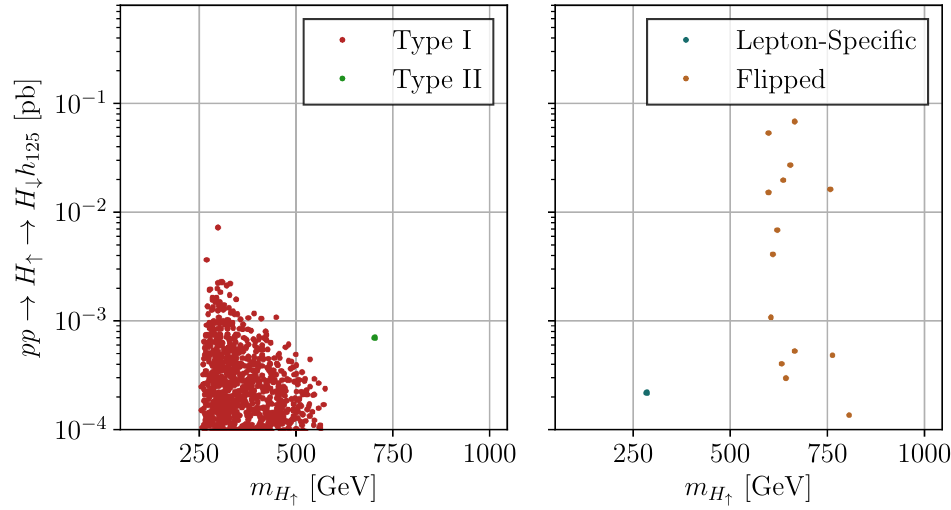
Figure 18 . Production rates for the process pp boson mass, for all C2HDM types (same as (cid:12)gure 17) but with the extra condition (cid:27) ( pp ZZ ) < 1